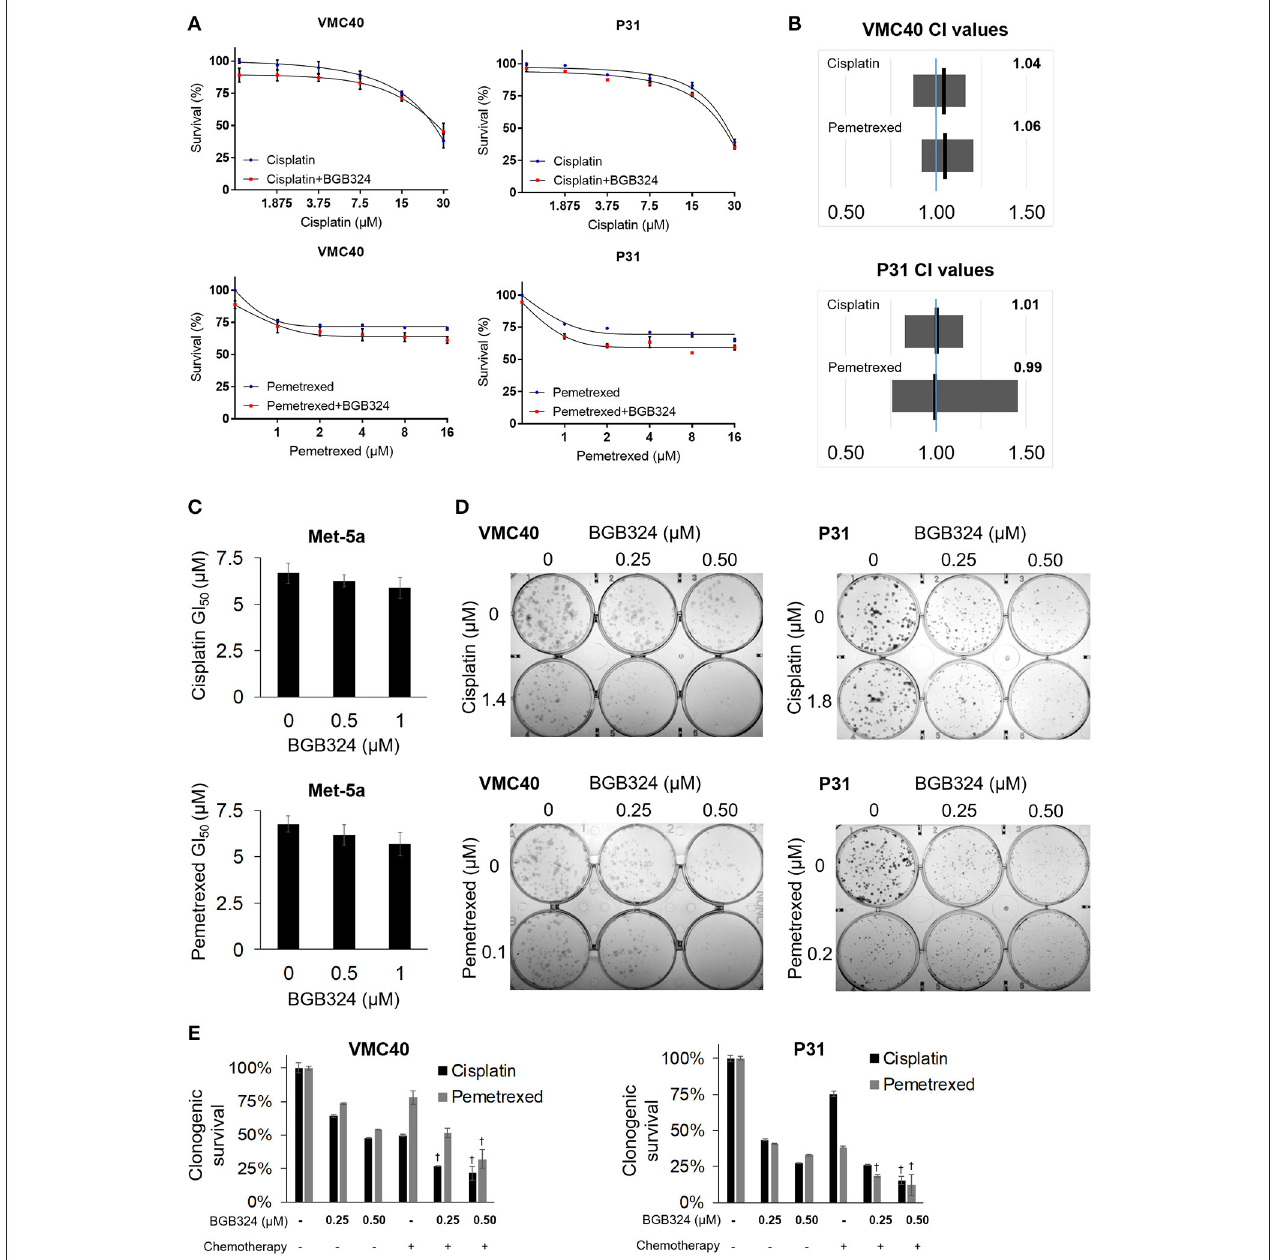
FIGURE 5 | Combination of BGB324 with cisplatin and pemetrexed enhances MPM cell death. (A) Cell survival for incrementing concentrations of cisplatin and pemetrexed with and without 0.5 µ M BGB324. Values determined by SRB assay at 72h. Actual values, dose-response curve of BGB324, and statistical analysis at specified concentrations are shown in Supplementary Figure 7. (B) CI range (gray box) and mean (black line) from full data shown in Supplementary Figure 7A. The reference value, 1.00, is indicated by a blue line. CI < 1.00 is considered synergistic. CI values calculated as described in section Materials and Methods. (C) GI 50 values for cisplatin and pemetrexed in nonmalignant Met-5a cells. (D) Representative images of clonogenic assays after 72h treatment and then allowing cells to form colonies in absence of drugs. (E) Quantification of clonogenic assays. † Denotes p < 0.05 via t -test for value compared to values of single agents. Error bars represent ± SEM of three experiments (A,C,E)